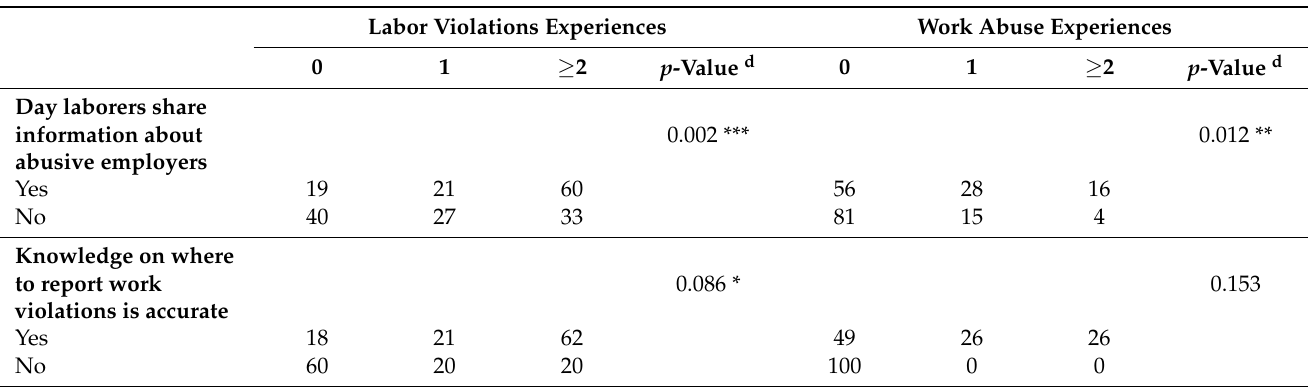
Table 7. Tests of independence between the incidence of labor violation or work abuse and resistance mechanisms a–c